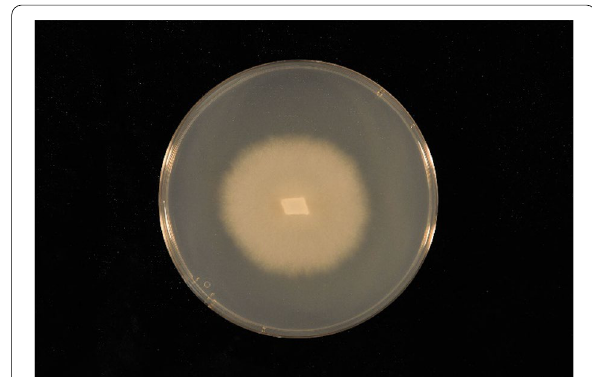
Fig. 1 Pure culture of Tulasnella calospora 266 (UAMH 9824) shown within a 9 cm diam. petri dish containing Potato Dextrose Agar > 10 days after inoculation. The culture is recognizable by the smooth, cream-colored mycelium and smooth colony margins. Photo courtesy of Michael E.